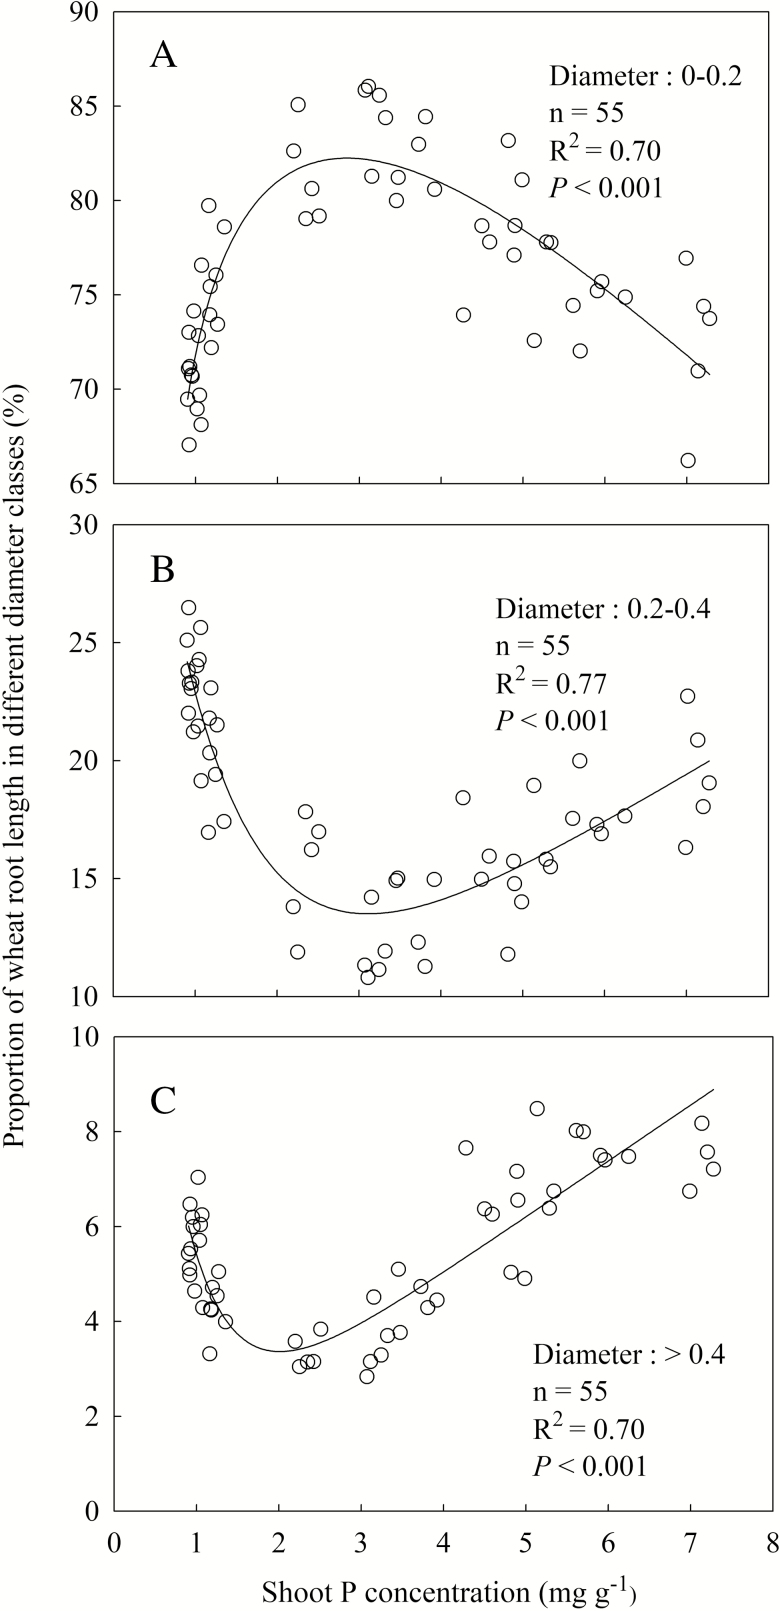
The proportion of root length with different diameter classes to total root length in response to increasing shoot P concentration. (A) Fine root in root diameter class: 0–0.2 mm; (B) medium-sized root in root diameter class: 0.2–0.4 mm; (C) thick root in root diameter class: >0.4 mm. Data point represents individual replicate.